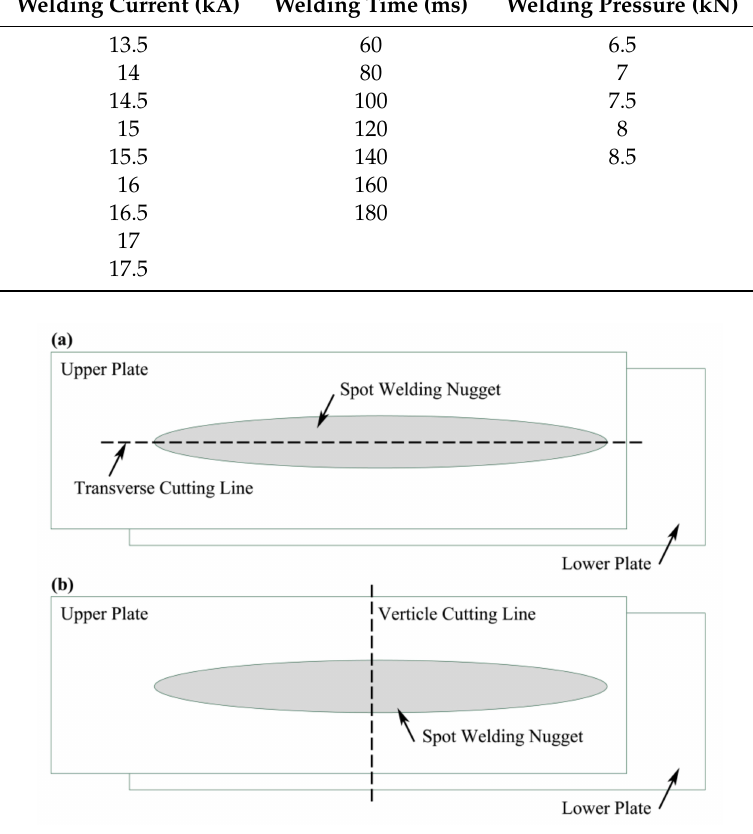
Figure 3. Cutting methods for metallographic samples of RSW joint: ( a ) transverse cutting and ( b ) vertical